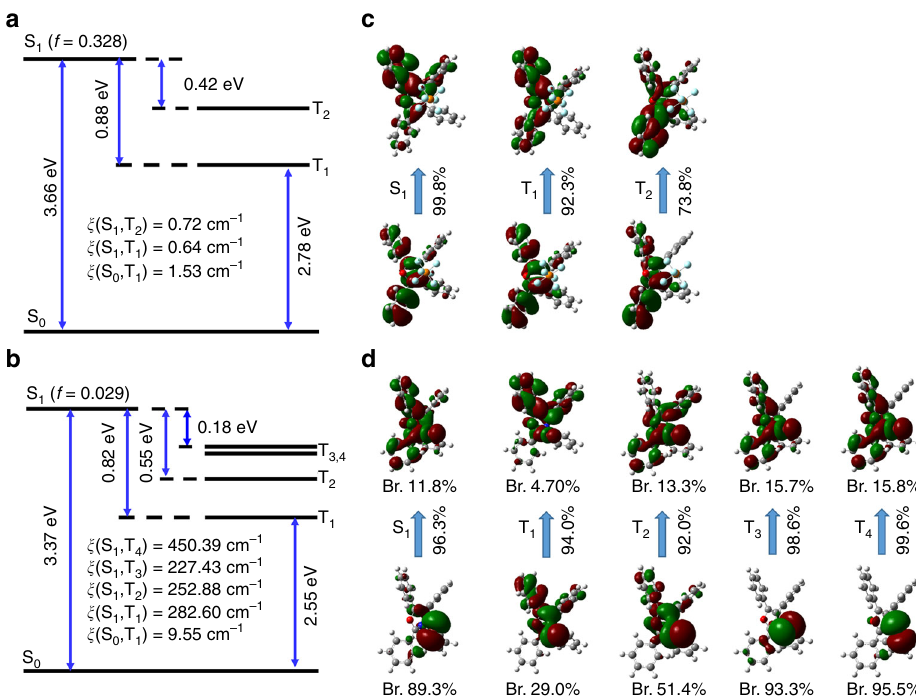
Fig. 3 Theoretical calculation for fl uorescence and RTP behaviors of organic salts. The calculated energy level diagram, spin – orbit couplings ( ξ ) between singlet and triplet states, and the oscillator strengths ( f ) of the S 1 state of a TPO-P and b TPO-Br in crystal based on the optimized ground-state geometries using ONIOM method. The natural transition orbitals (NTOs) (hole ones at the bottom and electron ones on the top) and the corresponding proportions for c TPO-P and d TPO-Br, as well as the bromine components in NTOs for